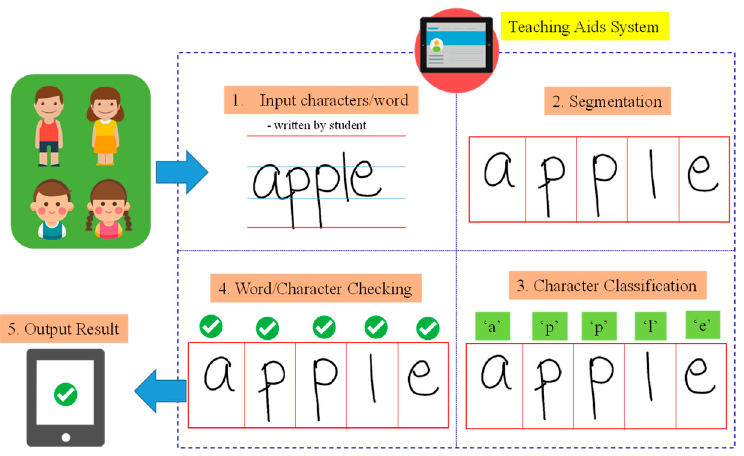
Figure 1. Overview of the target application.